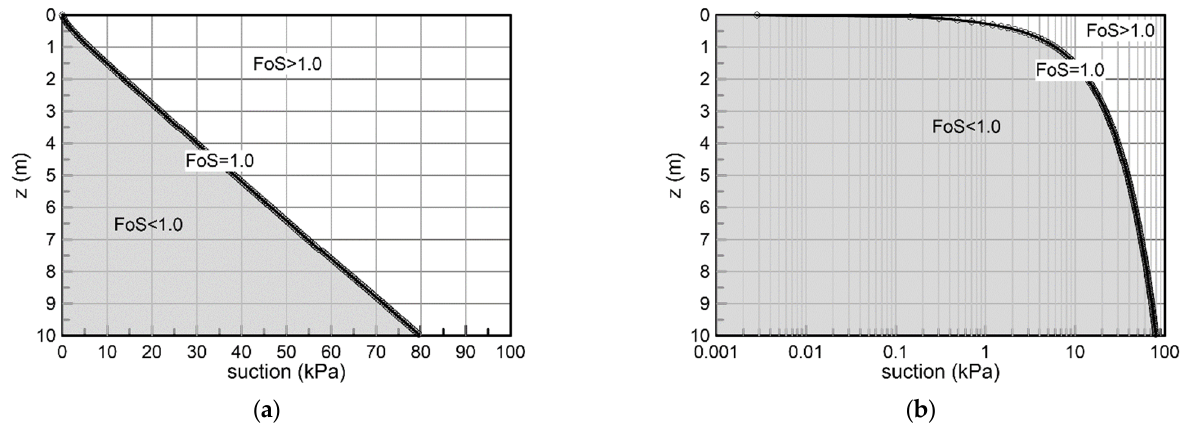
Figure 7. Stability chart; ( a ) stable vs. unstable suction and slope height combinations; ( b ) same as ( a ) in a semilogarithmic plot; results from a 2D mechanism (no lateral resistance).